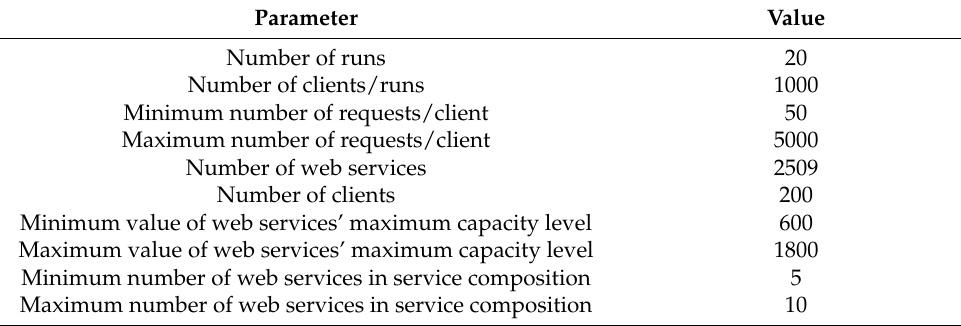
Table 1. Hybrid service-oriented architecture simulator setup